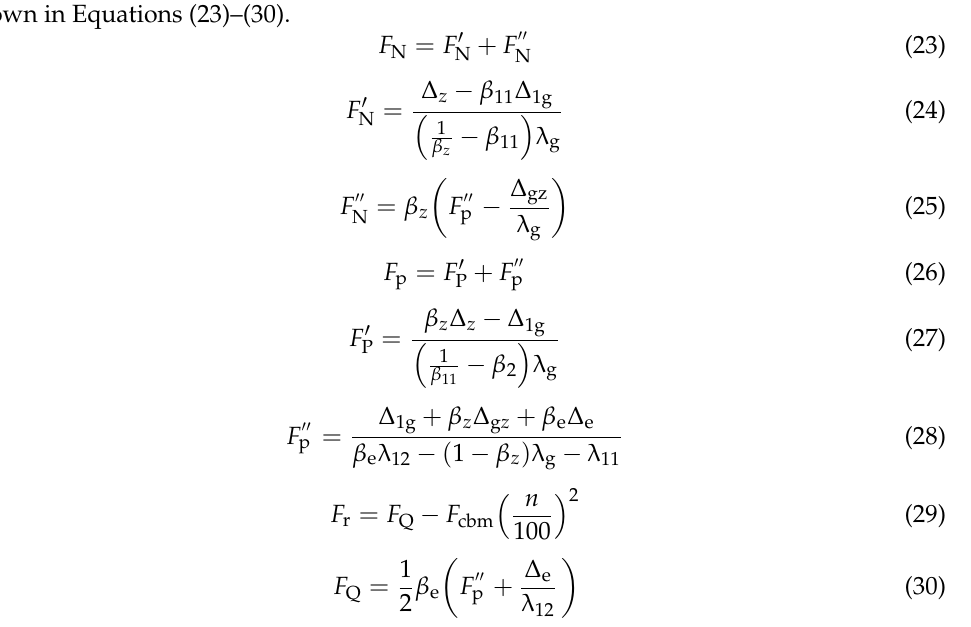
Figure 10. Mesh division of the rotor mechanism. The approximation techniques are one of the key research techniques for modern MDO problems. Approximate models can be used to improve the efficiency of solving complex model problems [60]. A second-order polynomial response surface is a widely used approximation technique. Modeling was carried out using a design of experiments approach. The second-order polynomial response surface method is adopted in this study. The coefficient  in Equation (25) can be obtained by the least-squares regression method and the orthogonal test [61]. (